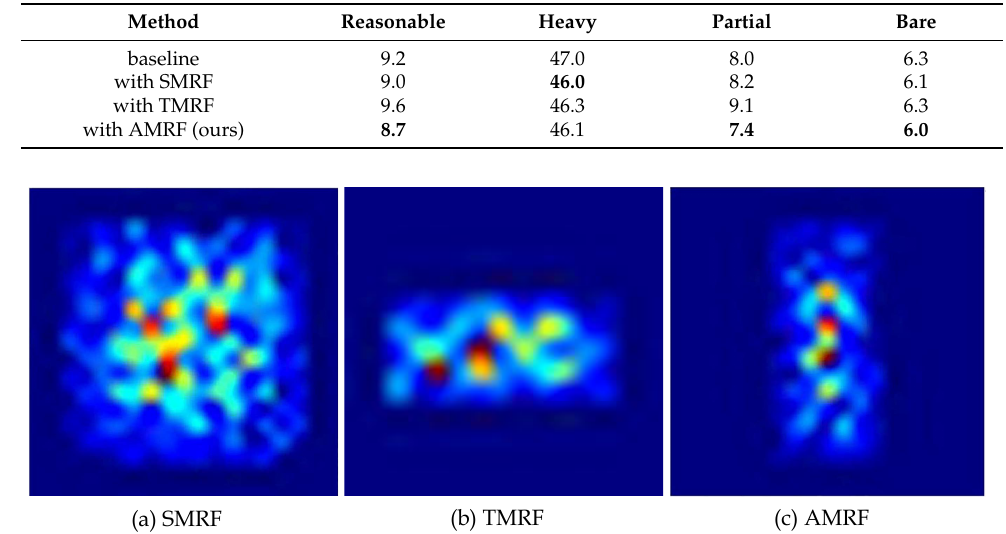
Table 6. The comparative experiments of SMRF, TMRF and AMRF. The best results are highlighted in bold.